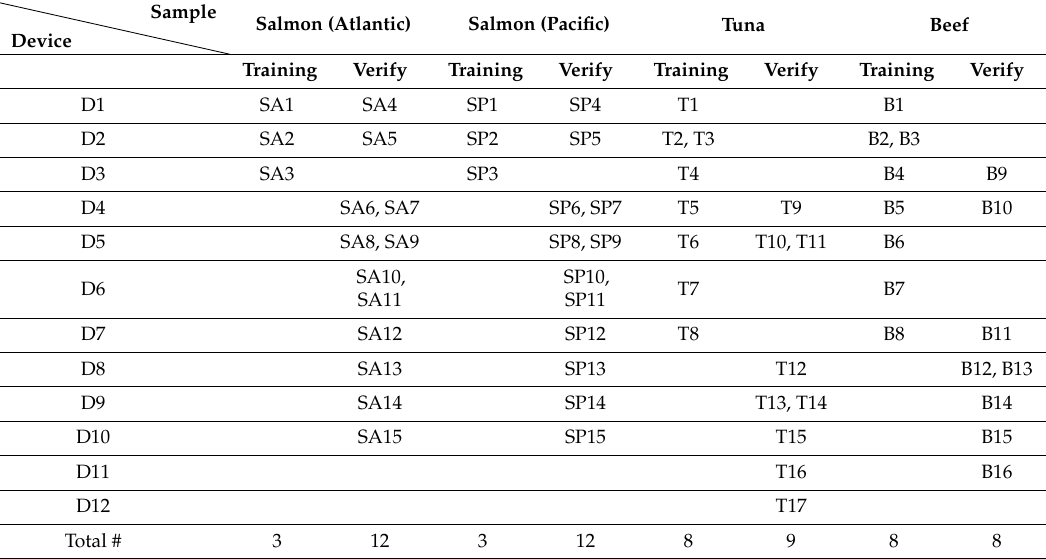
Table 1. Multiple LinkSquare devices were used in this study, and we have labeled them from A to L (12 units). Each food samples were labeled as follows: Salmon Atlantic (SA), Salmon Pacific (SP), Tuna (T), and Beef (B). The number of 15, 15, 17, and 16 samples were used respectively for both training and verification spectra